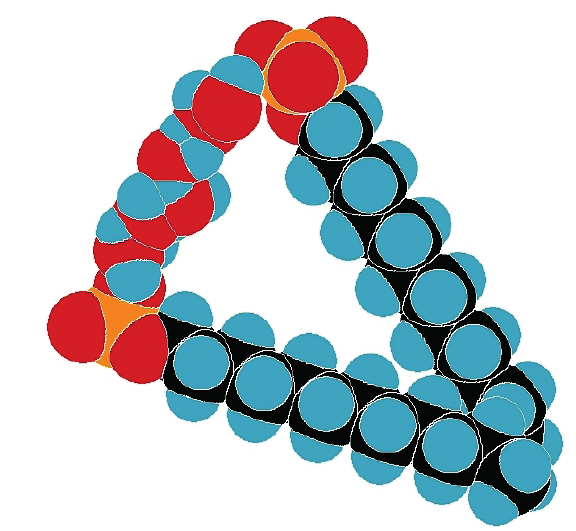
Figure 9: van der Waals model of SDS molecule with water molecules forming hydrogen bridging between sulfate